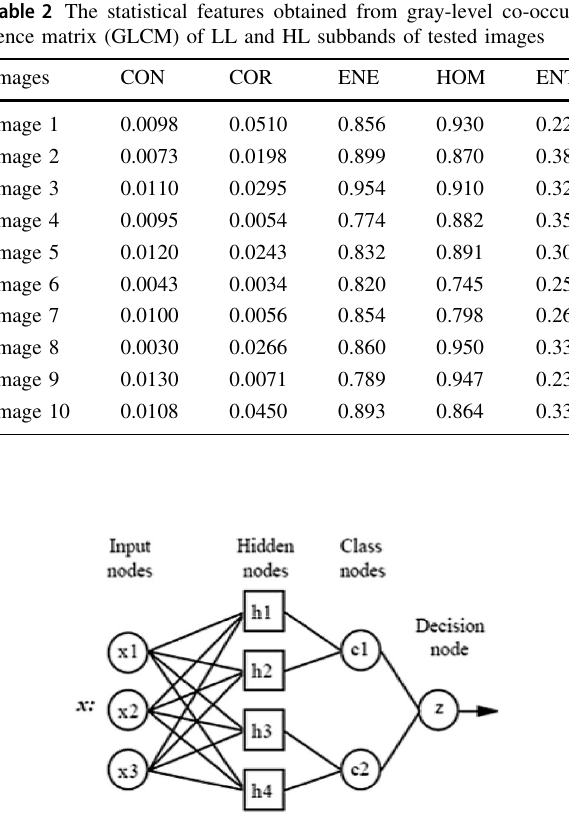
Fig. 1 Diagram of probabilistic neural networks